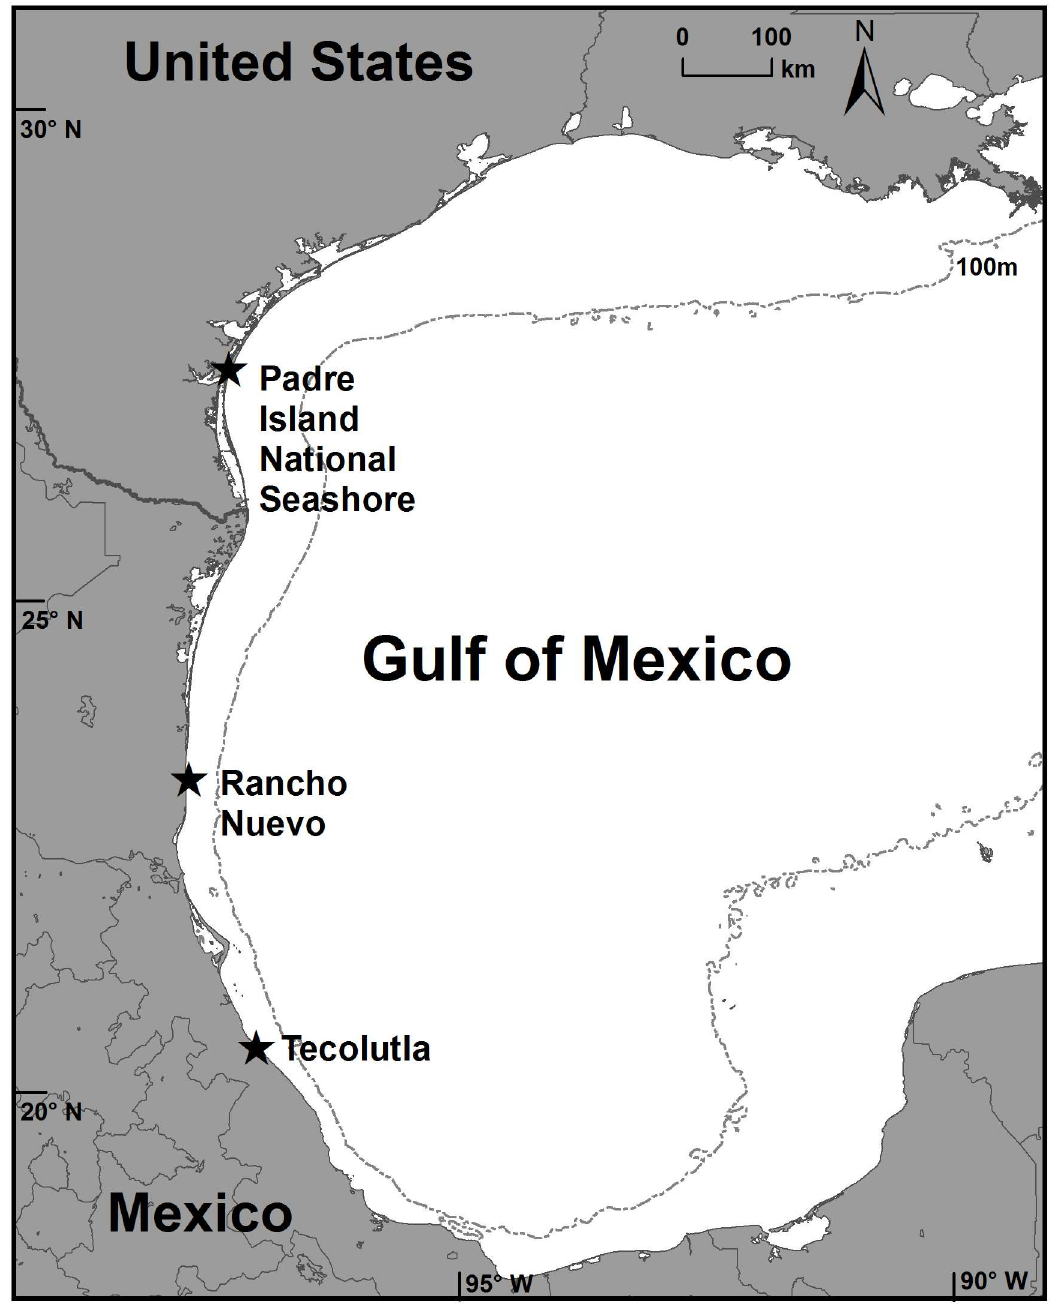
Fig 1. Tagging locations for n = 82 Kemp’s ridley turtles trackedby satellite telemetryin the Gulf of Mexico. Includesn = 60 tracked after nestingat Padre Island NationalSeashore, Texas, USA during1998 through 2013, n = 11 at RanchoNuevo, Tamaulipas, Mexico during2010 and 2011, and n = 11 at Tecolutla, Veracruz, Mexico during2012 and 2013.